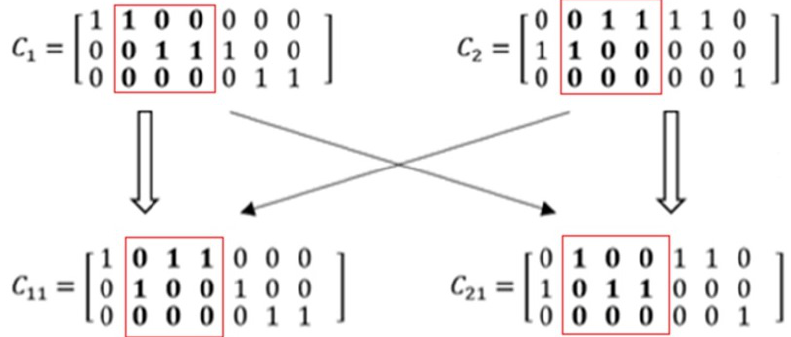
Figure 4. Illustration of the computing process in the partially mapped crossover